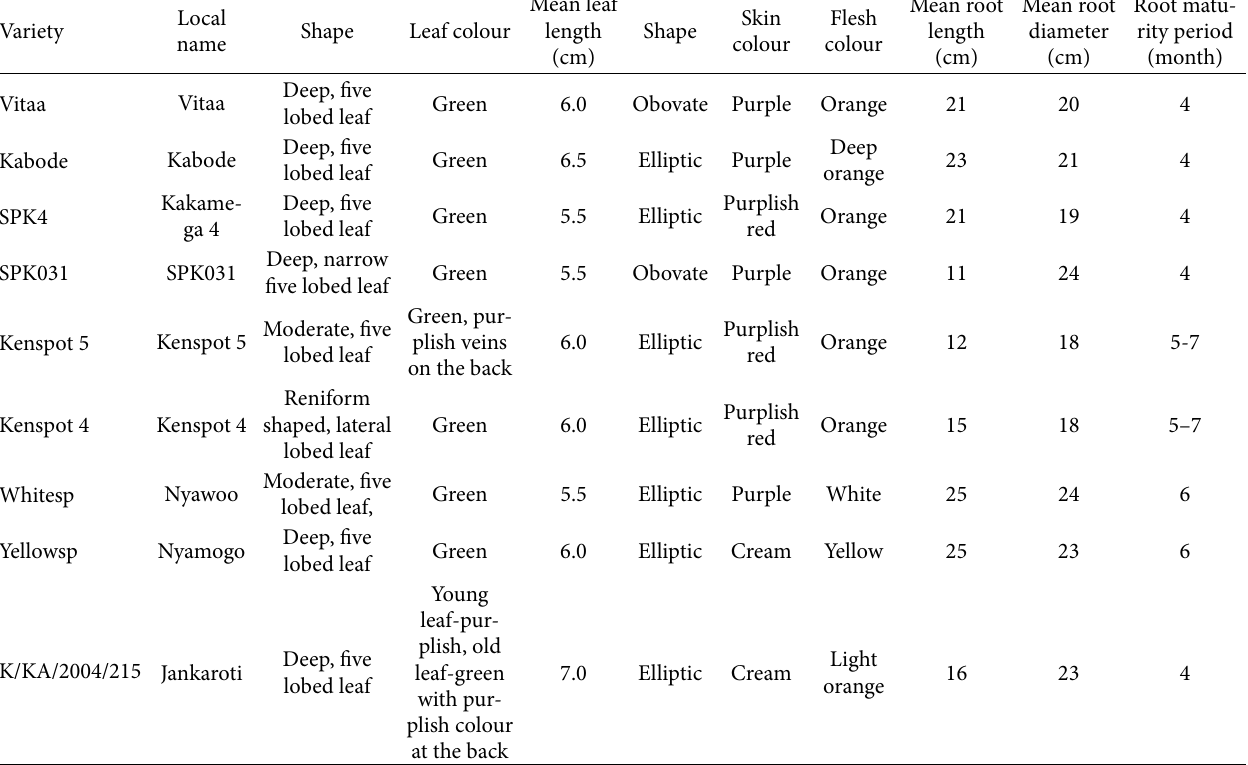
Leaf and root parameters are mean values of 10 representative samples for each